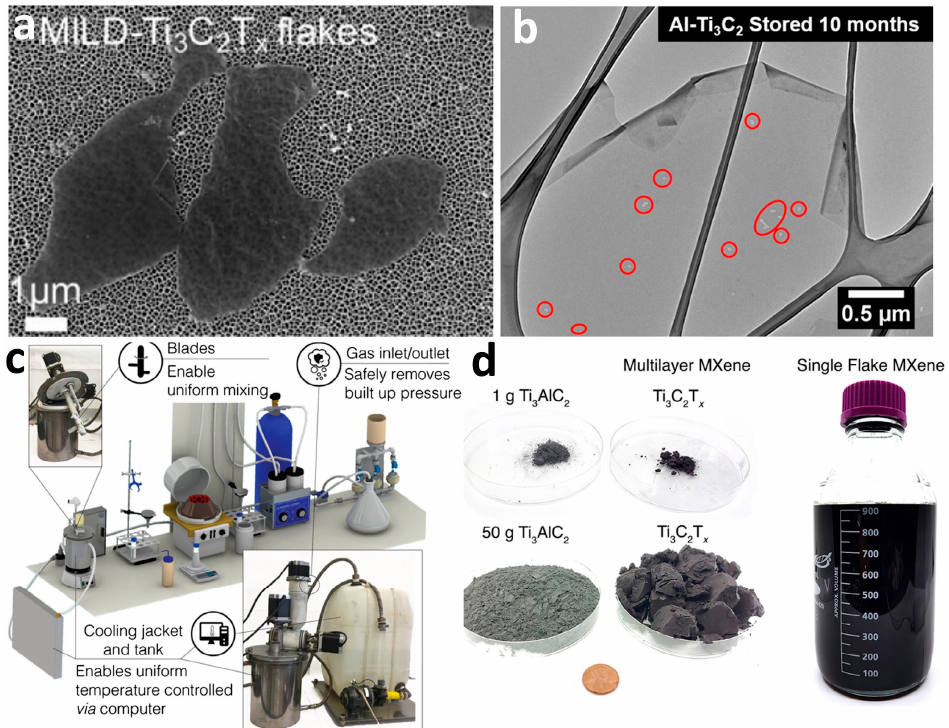
Figure 2. ( a ) SEM image of MILD-Ti 3 C 2 T x flakes; reproduced from [29], with the permission of the American Chemical Society. ( b ) TEM image of Al-Ti 3 C 2 stored for 10 months; reproduced from [20], with the permission of the American Chemical Society. ( c ) Schematic of MXene scalable synthesis. ( d ) Comparison of small and large batches of synthesized MXene; reproduced from [34], with the permission of Wiley-VCH.